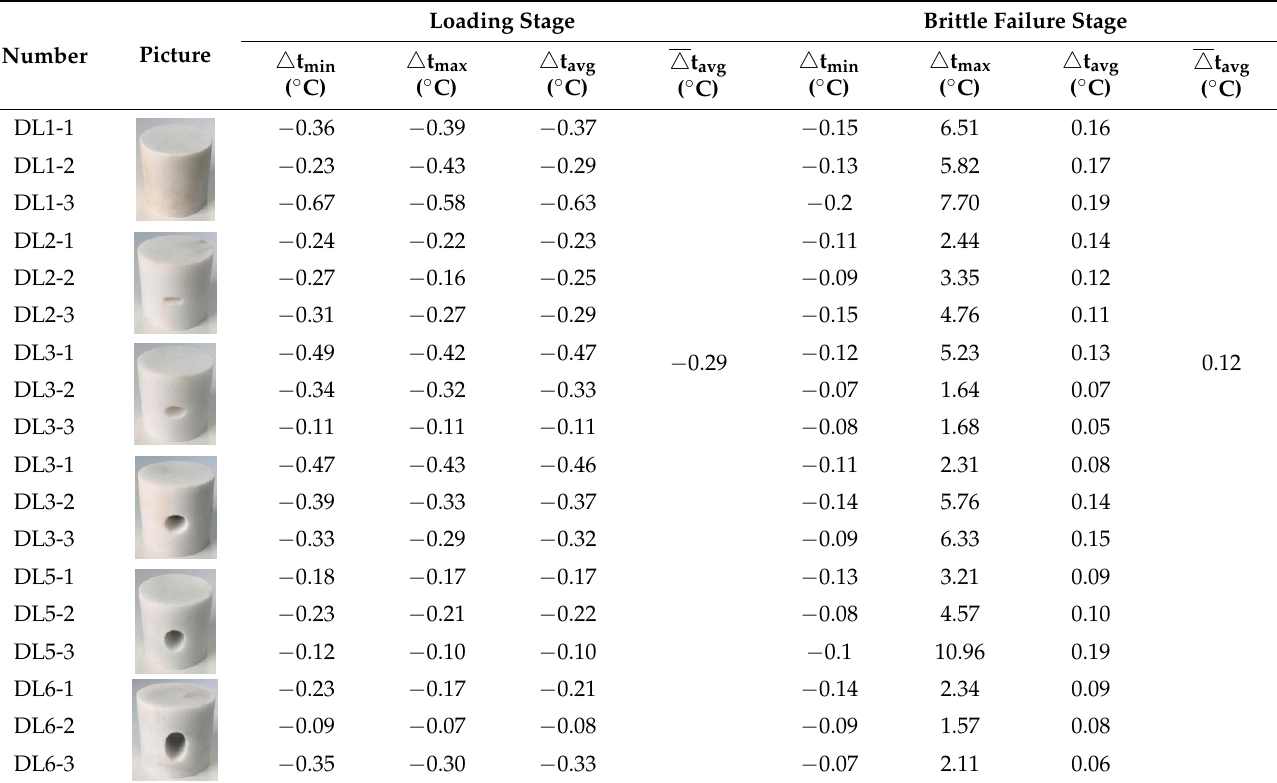
Table 2. Temperature variation of all rock samples during the failure process.